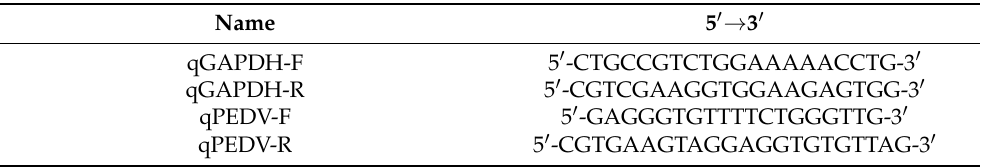
Table 1. Primers for quantitative real-time